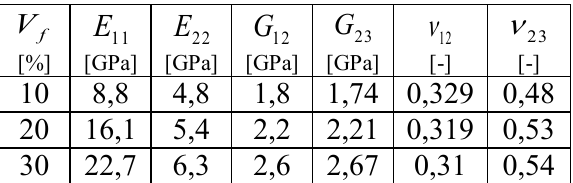
Tab. 1. Mechanical properties of composites with epoxy matrix reinforced with glass fibers